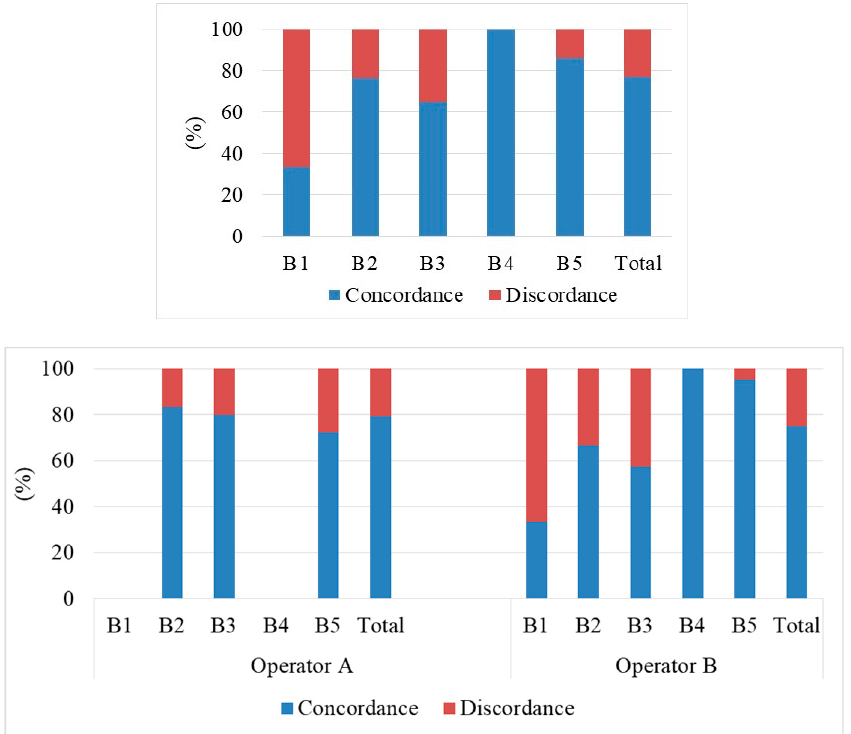
Figure 7. Assessment of the radio-pathological concurrence compared to the post-operative conclusive histology results of patients who underwent the Elite VABB procedure.